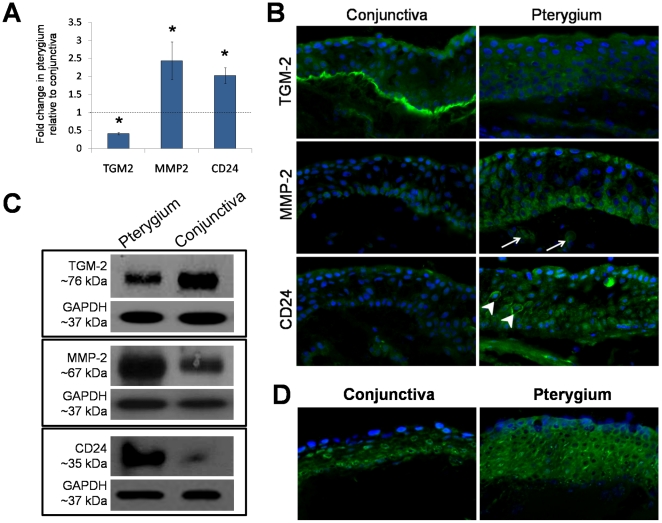
Protein level and localization, as well as transcript level of transglutaminase 2 (TGM-2), matrix metalloproteinase 2 (MMP-2), and CD24 in pterygium compared to conjunctiva.(A) Fold change of TGM-2, MMP-2, and CD24 gene transcript in the pterygium tissue relative to the conjunctiva tissue. Height of the bars represents mean value and error bars represent standard error of the mean. Dashed line represents the transcript levels of the conjunctiva. *p<0.05. (B) Immunofluorescent staining of TGM-2, MMP-2, and CD24. Nuclei were stained with DAPI present in the mounting medium. Arrows indicate fibroblasts that were positive with MMP-2. Arrowheads indicate staining of CD24 in the plasma membrane of epithelial cells. All images were taken at 400X magnification. (C) Western blot analysis of TGM-2, MMP-2, and CD24 proteins expressed in human conjunctiva and pterygium tissue. GAPDH was used as the loading control. (D) In situ zymogram showing gelatinolytic activity in the pterygium and conjunctiva tissue. Images were taken at 400X magnification.